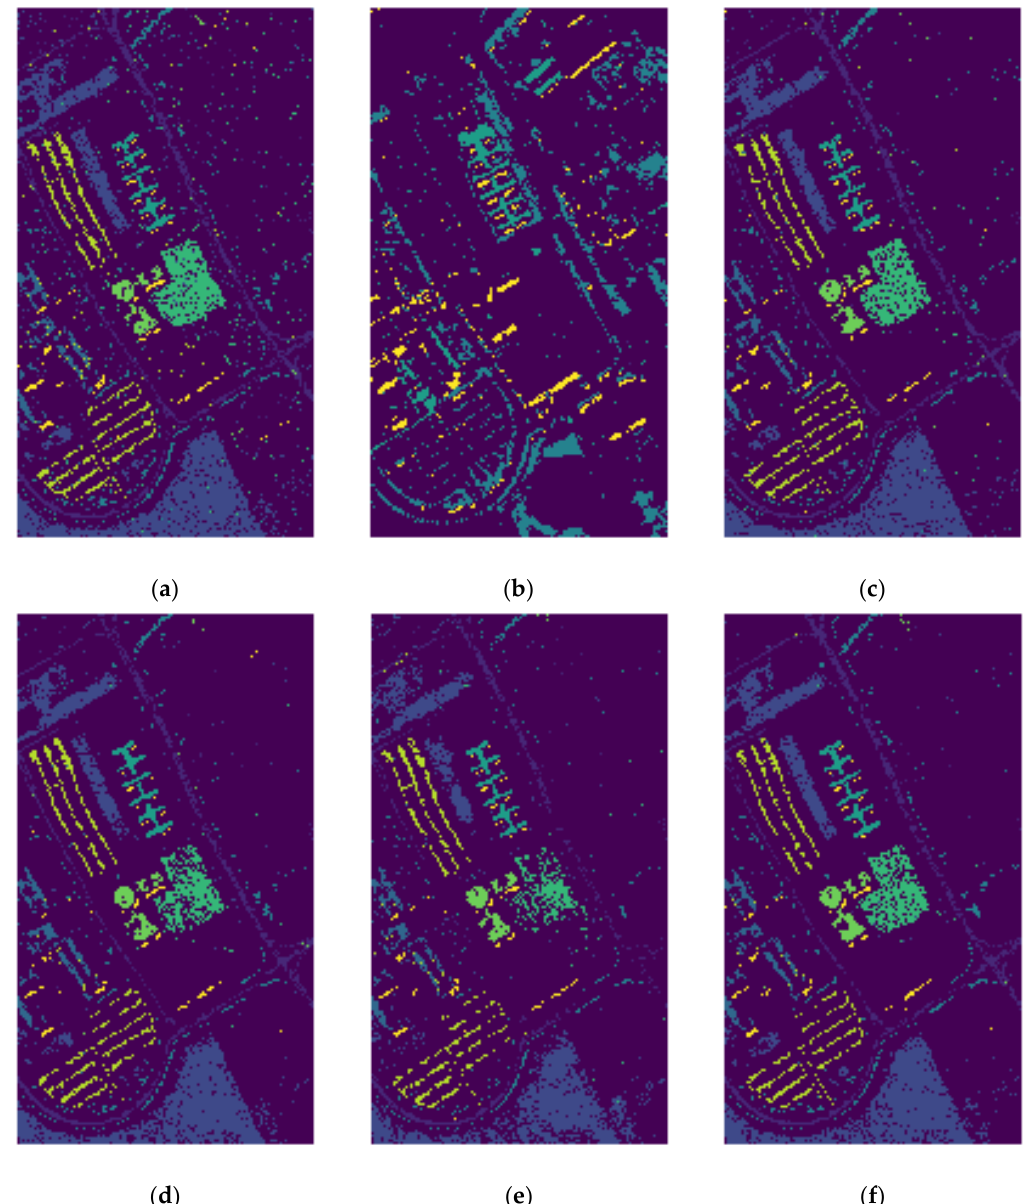
Figure 16. Classification results for Pavia University data. ( a ) DT, ( b ) AdaBoost, ( c ) GBM, ( d ) XGBoost, ( e ) Light GBM, and